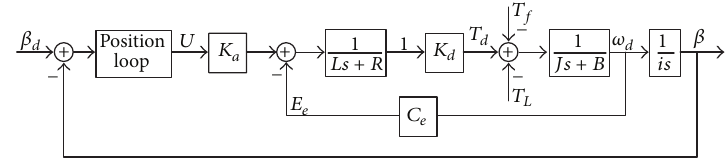
Figure 1: Schematic of the AC servosystem of